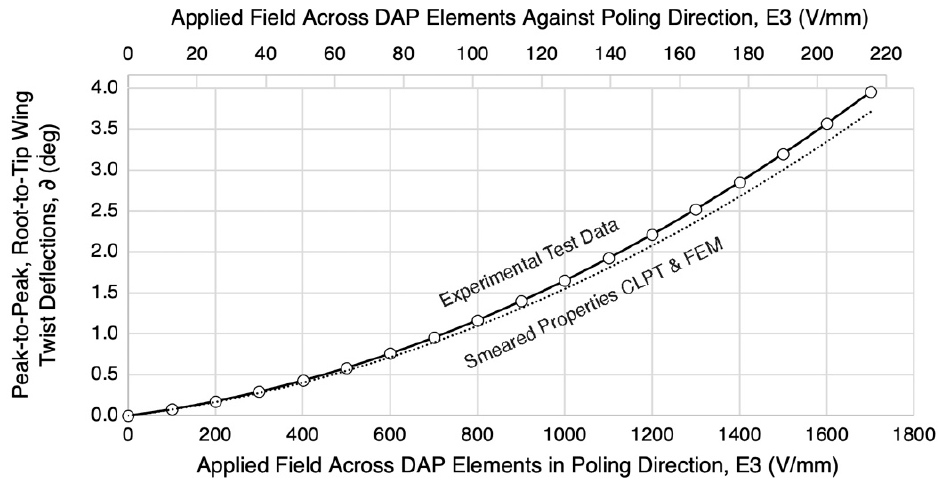
Figure 10. Quasi-static twist deflection results.